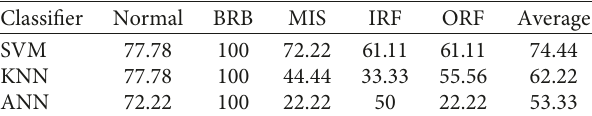
Table 9: Classification accuracy of the current signal by different classifiers (%).